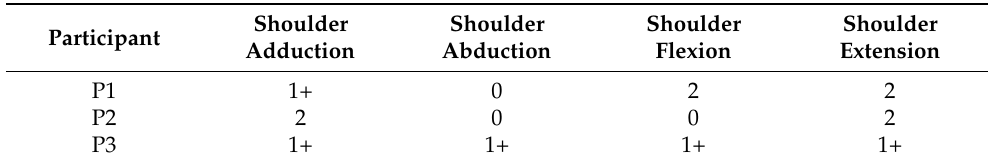
Table 1. Modified Ashworth Scale (MAS) scores of the enrolled participants at baseline for the impaired